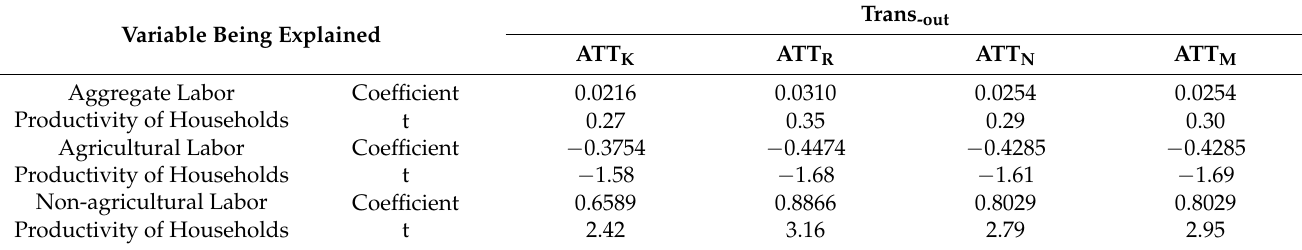
Table 11. Basic Estimation Results of ATT for the Productivity of Land Transfer-out Households. Variable Being Explained